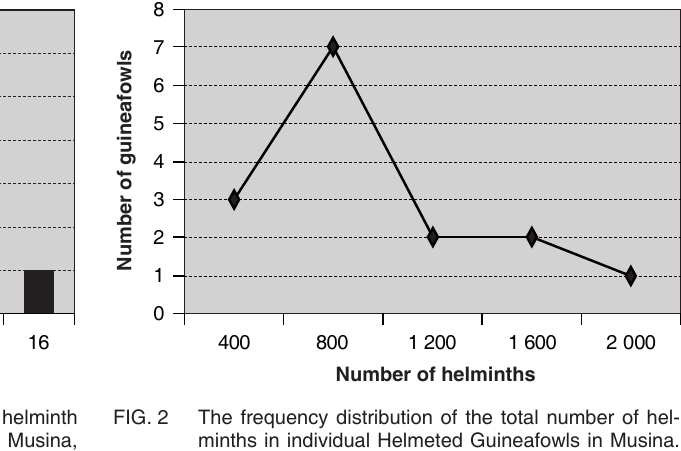
FIG. 1 Frequency distribution of the total number of helminth species found in Helmeted Guineafowls in Musina, Lim popo Province, South Africa. The number of indi- vidual hosts infected by a certain number of helminth species is indicated by the vertical bars